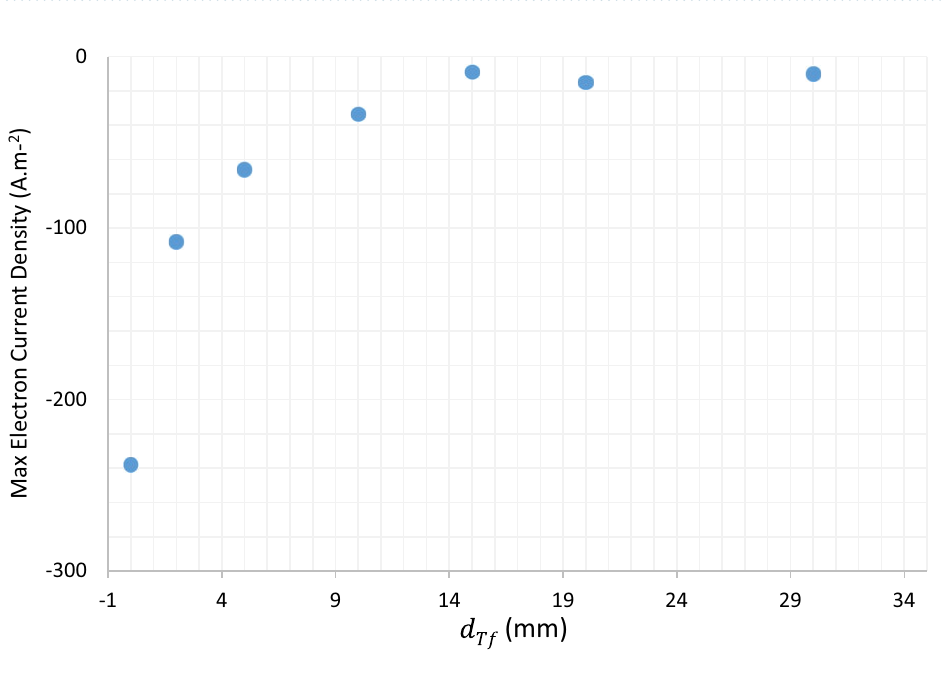
Figure 4. Electron current density at t = 150 ns